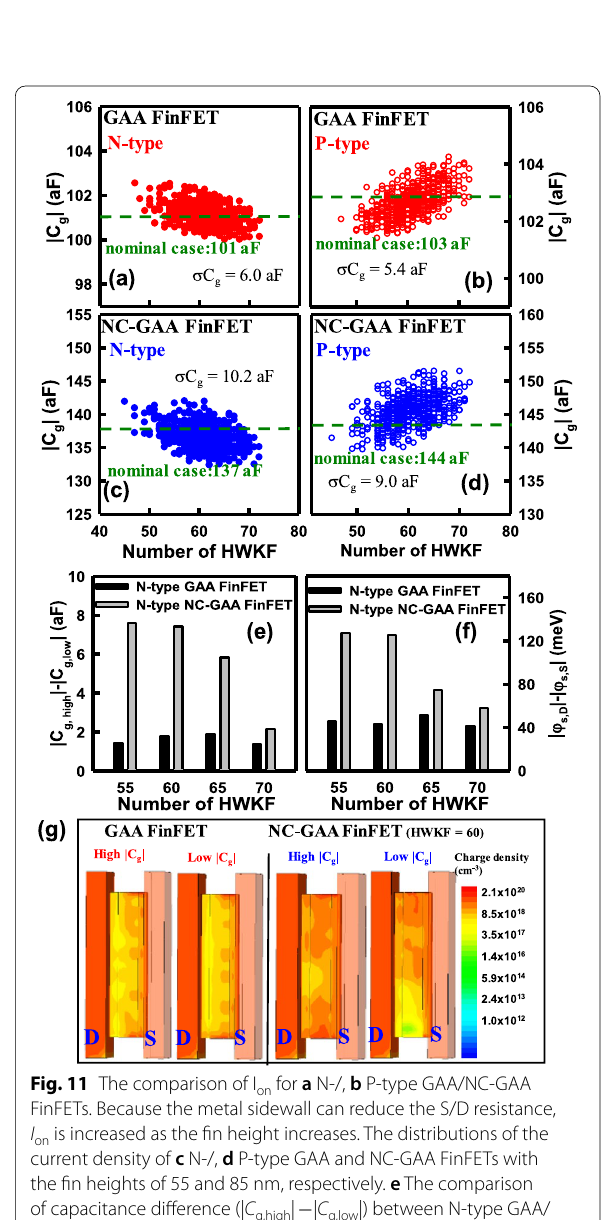
Fig. 11 The comparison of I on for a N‑/, b P‑type GAA/NC‑GAA FinFETs. Because the metal sidewall can reduce the S/D resistance, I on is increased as the fin height increases. The distributions of the current density of c N‑/, d P‑type GAA and NC‑GAA FinFETs with the fin heights of 55 and 85 nm, respectively. e The comparison | C g,low |) between N‑type GAA/ of capacitance difference (| C g,high | − NC‑GAA FinFETs under different HWKF numbers. f The surface potential (| φ s,D | | φ s,S |) comparison of two devices under the different − HWKF numbers. g The charge density distribution of two devices under the same HWKF